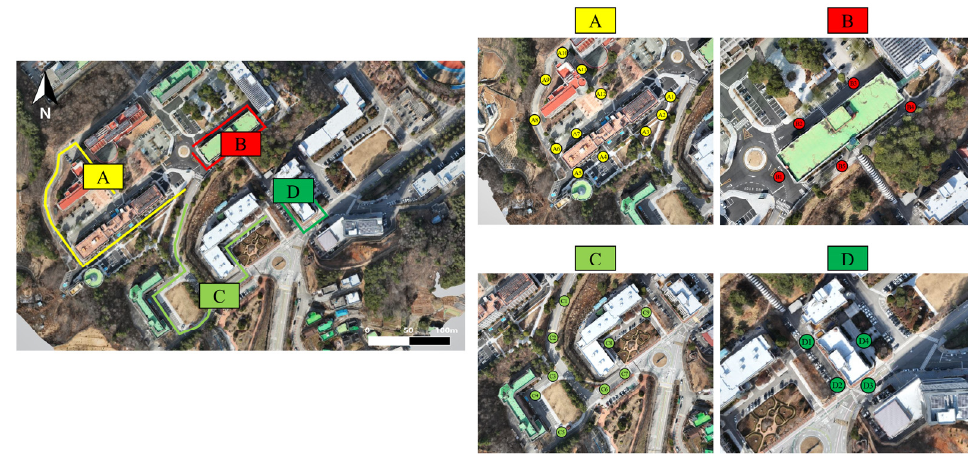
Figure 9. A total of 4 areas (A, B, C, D) and 31 analysis points in the study area.